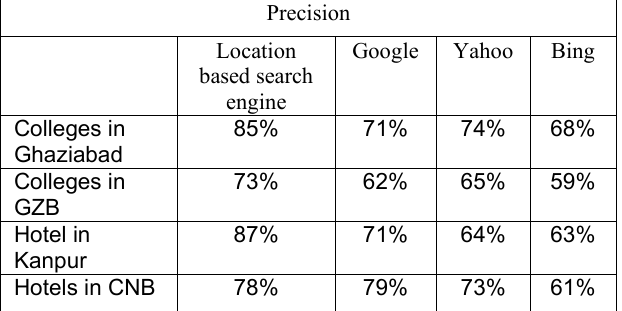
Figure 6 . User Interface